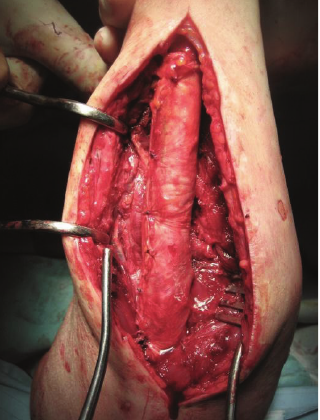
Figure 5: Allogenic cadaver graft of fascia lata was double-wrapped around the ulna and sutured on itself.